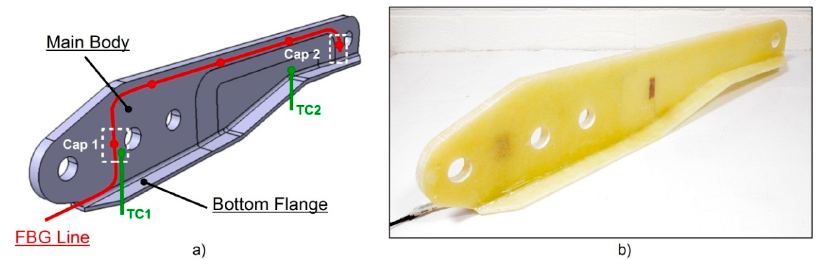
Figure 4. 3D concept drawing ( a ) and real component with embedded sensors ( b ) for the A380 hinge arm.